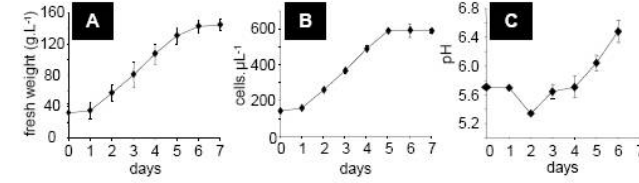
Fig. 3 - Growth pattern of Cakile maritima cell suspension determined by fresh weight (A) or cell density measurements (B). Evolu- tion of the medium pH during cell suspension growth (C). Bars indicate mean ± SD of at least three